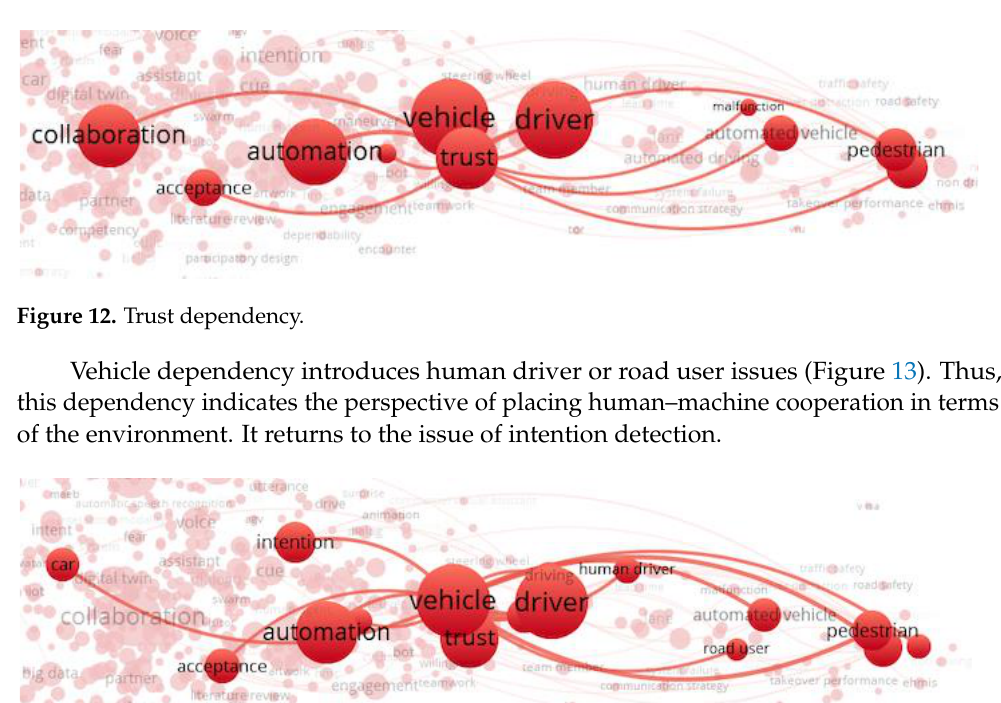
Figure 14. Driver dependency.